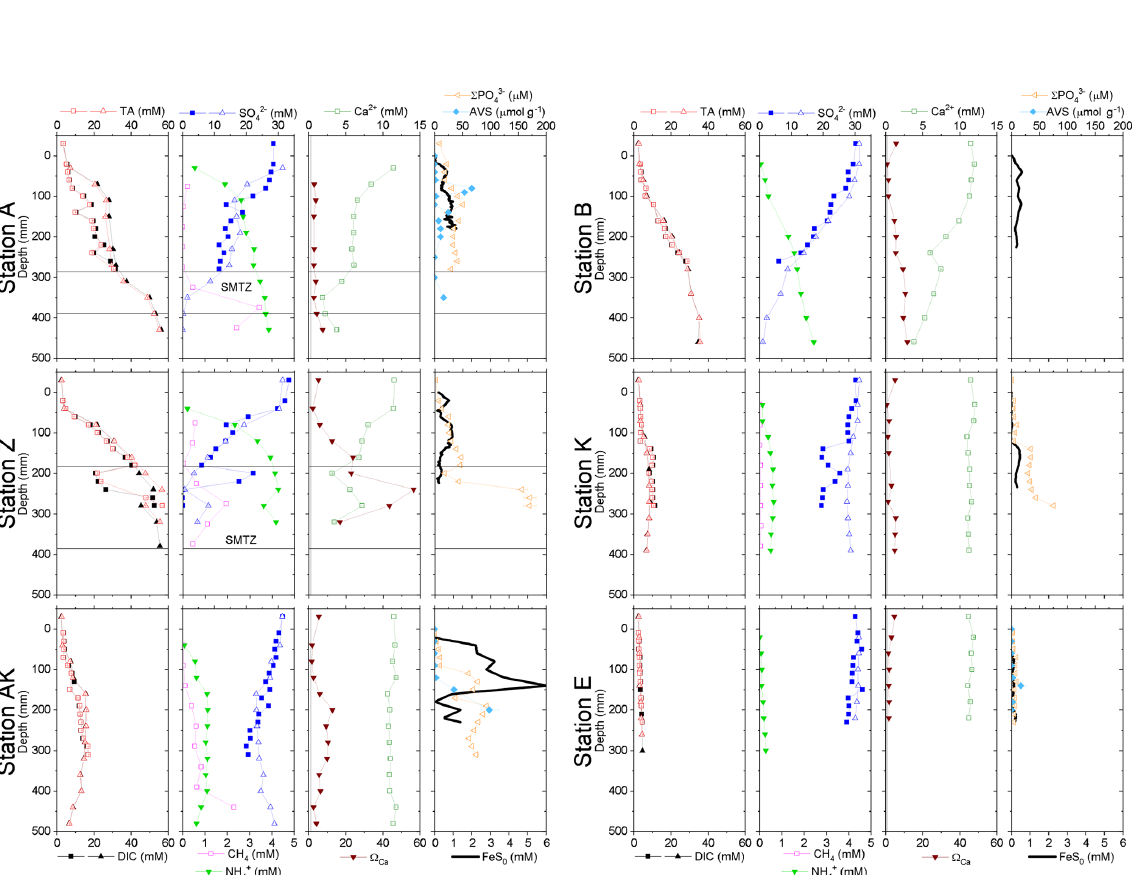
Figure 5. Depth profiles of pore water TA, DIC, SO 2 − , NH + , CH 4 , Ca 2 + , nanoparticulate FeS (FeS 0 ), (cid:54) PO 3 − and AVS concentrations, 4 4 4 along with the calcium carbonate (calcite) saturation state of the pore waters ( (cid:127) Ca ) at stations A, Z, AK, K, B and E. Alternating symbol shapes indicate data collected from duplicate long and short sediment cores. The calcium carbonate (calcite) saturation state ( (cid:127) Ca ) and pore water FeS 0 concentrations were calculated, whereas AVS was determined from solid-phase extractions. The two horizontal lines identify the sulfate–methane transition zone (SMTZ) found at stations A and Z. Error bars represent standard deviations of multiple measurements for the concentrations and error propagation for (cid:127) . Concentrations of CH 4 were not measured at stations B, K and